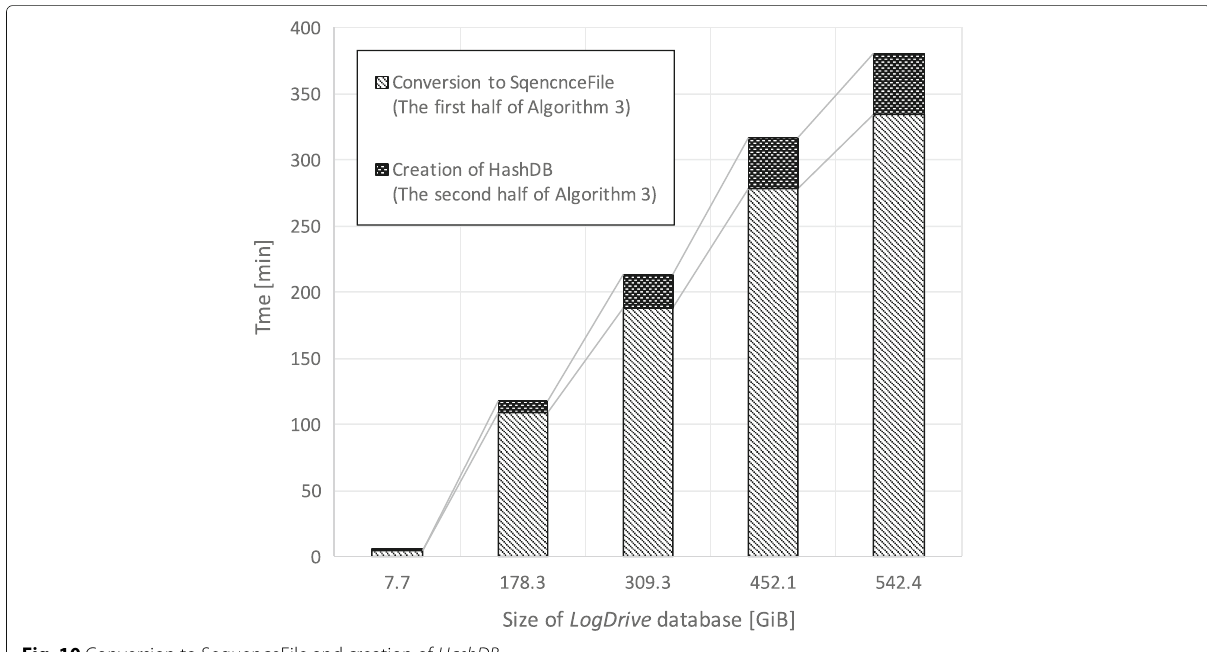
Fig. 10 Conversion to SequenceFile and creation of HashDB